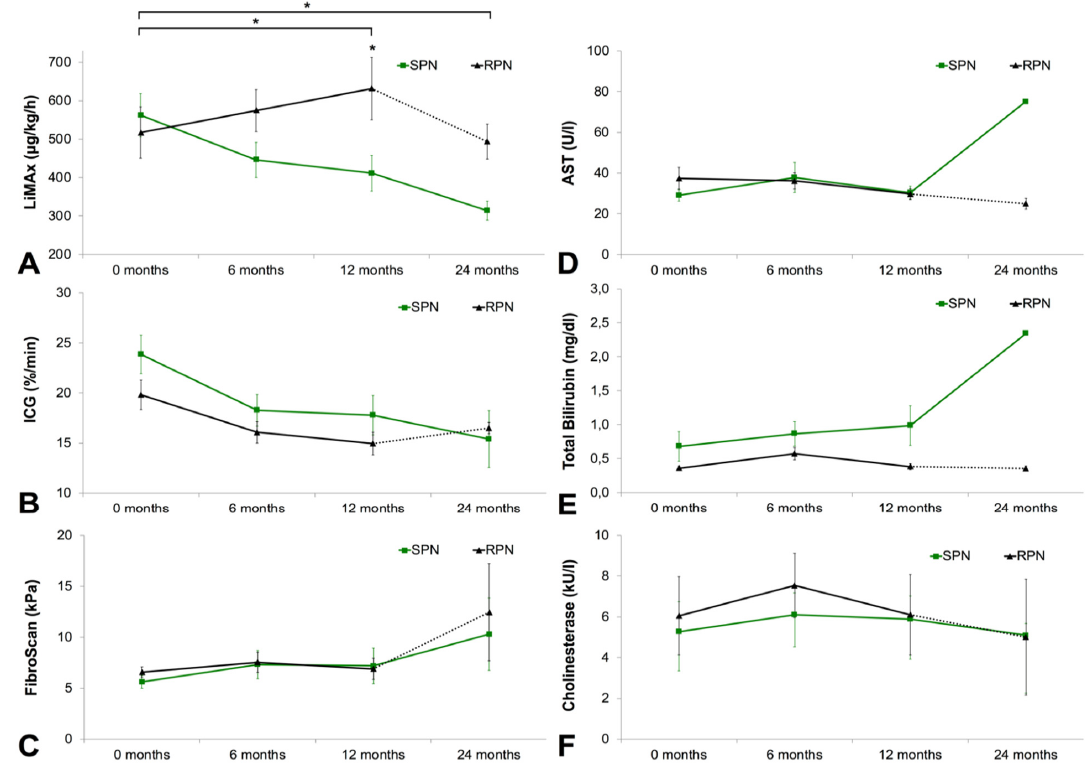
Figure 3. Liver function over time as determined by liver function tests. ( A ) LiMAx test; ( B ) ICG test; ( C ) FibroScan; ( D ) AST; ( E ) Total Bilirubin; ( F ) Cholinesterase. Data presented as mean ± standard deviation. RPN group presented in dashed lines between the 12- and 24-month time points due to reduced sample size as a consequence of PN weaning. *, p < 0.05; AST, aspartate aminotransferase; LiMAx, maximum liver function capacity; ICG, indocyanine green; RPN, reduced parenteral nutrition; SPN, stable parenteral nutrition.